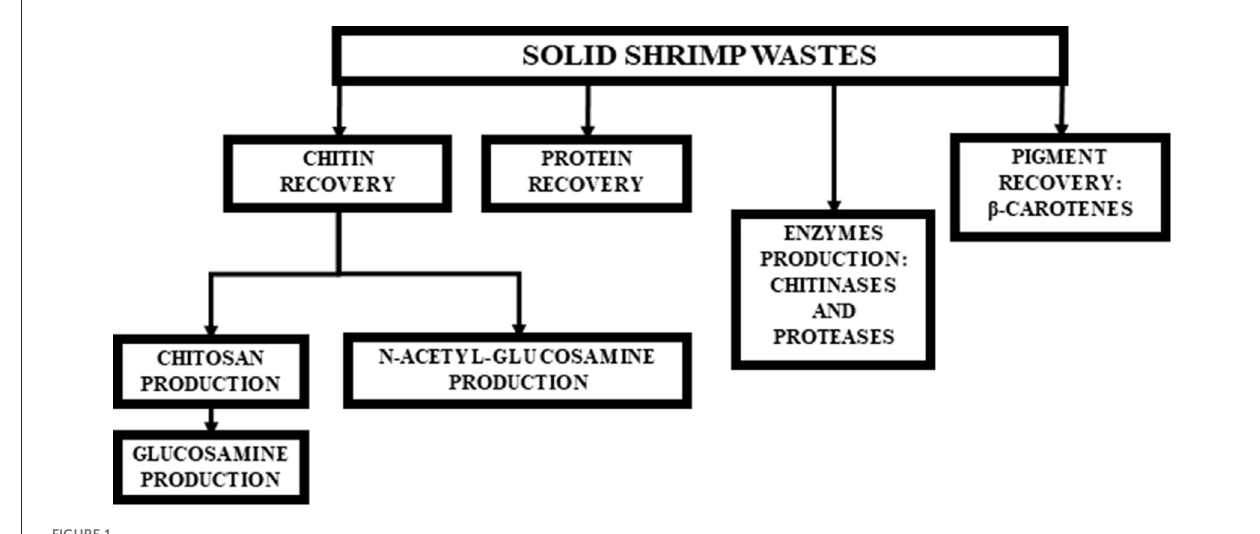
FIGURE1 Technological alternatives for integral use of shrimp solid wastes.